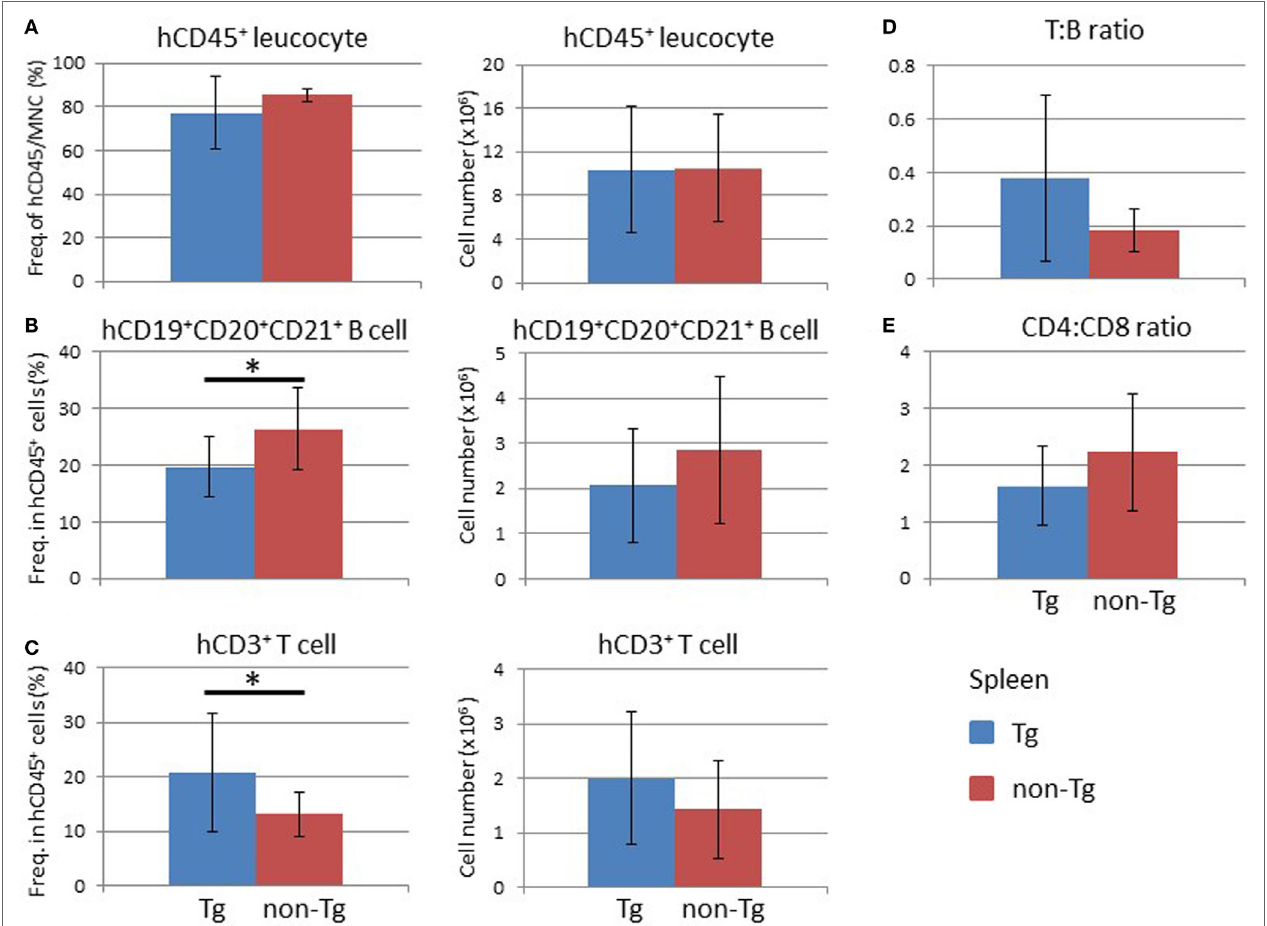
FigUre 6 | Analysis of human cells in the mouse spleen. Splenocytes were prepared from the spleens of NOG-pROR γ t- γ c Tg and NOG non-Tg mice for fluorescence-activated cell sorting analysis at 24 weeks after HSC transplantation. (a) Frequency and absolute number of human CD45 + cells in total mononuclear cells. (B,c) Frequencies and absolute numbers of human CD19 + B cells (B) and human CD3 + T cells (c) among human CD45 + cells. (D) Human T to B cell ratio in human CD45 + cells. (e) The CD4 + T cell to CD8 + T cell ratio in human T cells. Mean ± SD from NOG-pROR γ t- γ c Tg ( n = 12) and NOG non-Tg mice ( n = 11). Asterisk indicates statistical significance (* p <